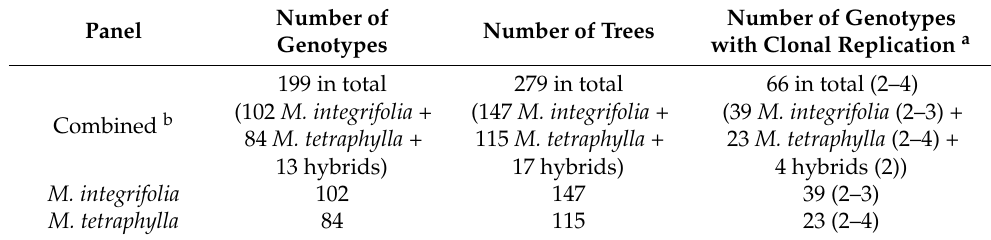
Table 1. Number of individuals in three germplasm panels used for